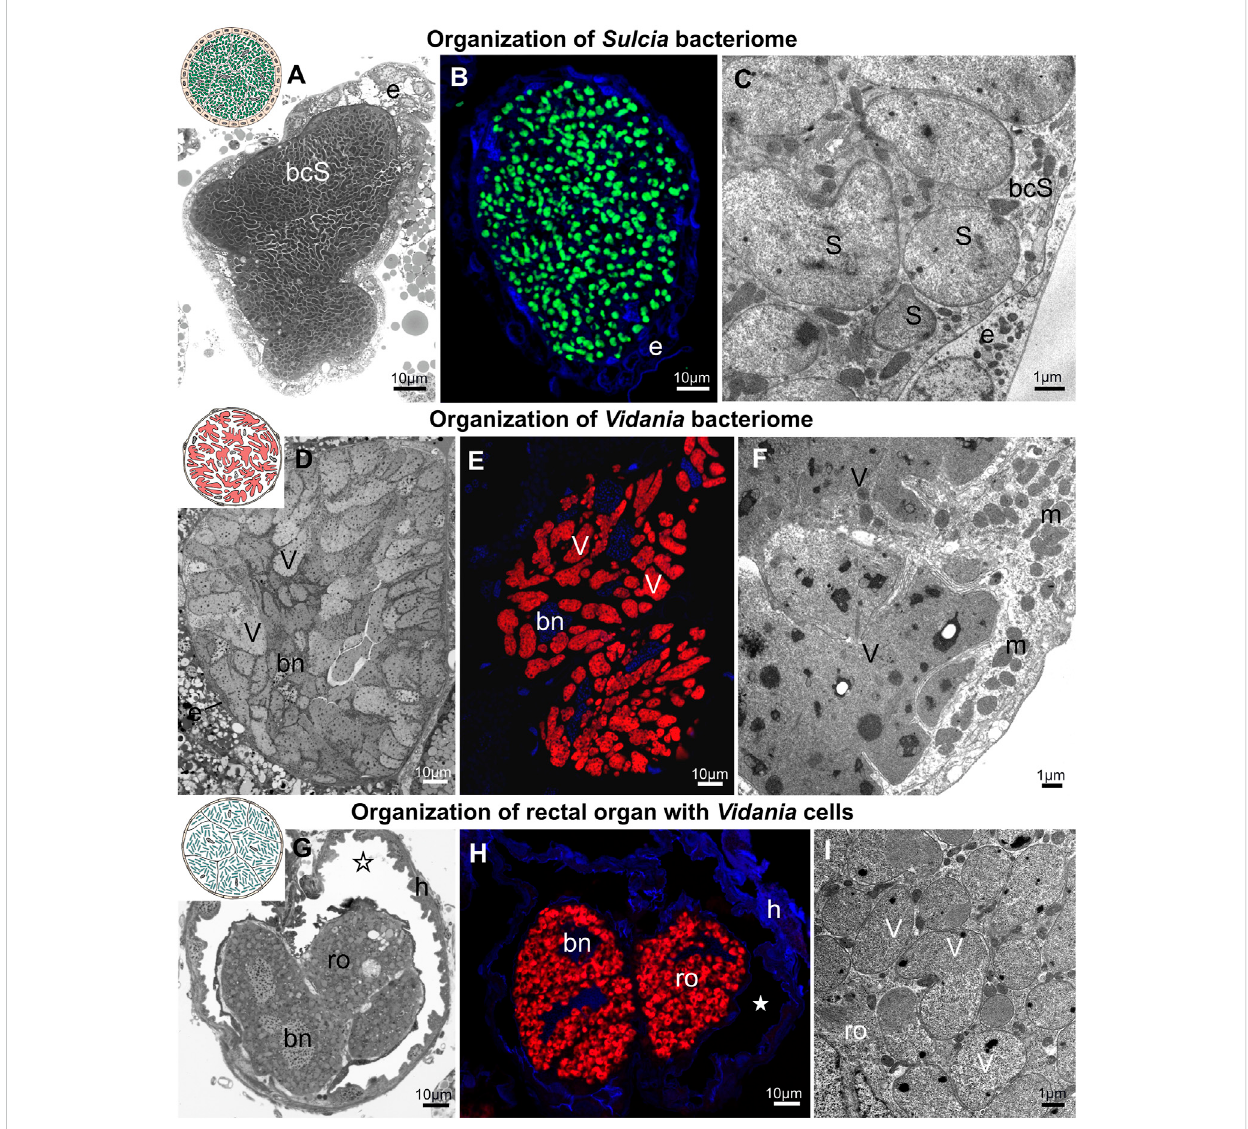
Bacteriome structure and morphology of ancient planthopper symbionts Sulcia and Vidania . (A) Organization of Sulcia bacteriome (B) Visualization of bacteriomes inhabited by Sulcia using Sulcia -speci fi c probe (green), blue represents DAPI, (C) Ultrastructure of Sulcia cells. (D) Organization of the Vidania bacteriome. (E) Visualization of bacteriome inhabited by Vidania using Vidania -speci fi c probe (red), blue represents DAPI (F) Ultrastructure of Vidania bacteriome (G) Rectal organ with Vidania symbiont in the hindgut lumen. (H) FISH detection of Vidania in the rectal organ. (I) Ultrastructure of Vidania cells in the rectal organ. For a detailed description of these images, see the main text. (A,D,G) Light microscope (LM). (B,E,H) Confocal microscope. (C,F,I) Transmission electron microscope (TEM). bcS - Sulcia bacteriocyte, bn - bacteriocyte nucleus, e - epithelium, h - hindgut, m - mitochondria, ro - rectal organ, asterisk - gut lumen, S - Sulcia , V - Vidania . Insect species: (A) Tettigometra sulphurea (Tettigometridae) (B) Akotropis quercicola (Achilidae) (C) Meenoplus albosignatus (Meenoplidae) (D,E) Tettigometra sulphurea (Tettigometridae) (F) Ommatidiotus